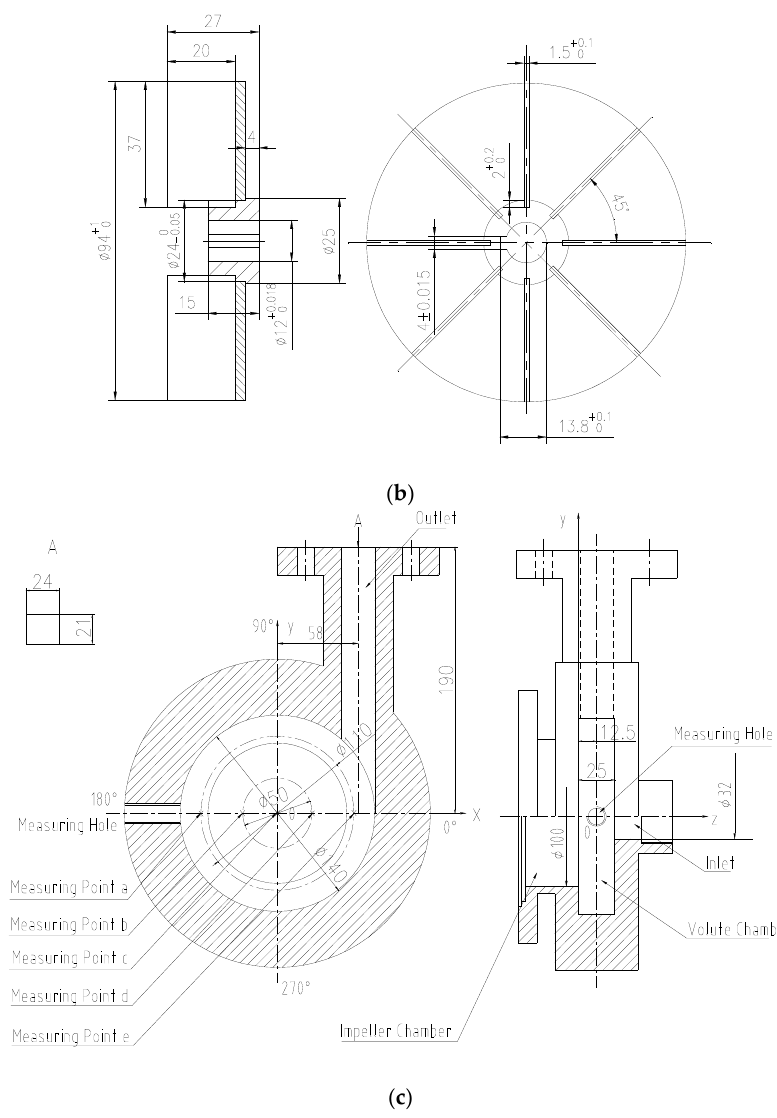
Figure 1. Structure and distribution of the hydraulic geometric sketch. ( a ) Structure diagram of the vortex pump; ( b ) Impeller component and geometric parameters; ( c ) Chamber component and geometric parameters.